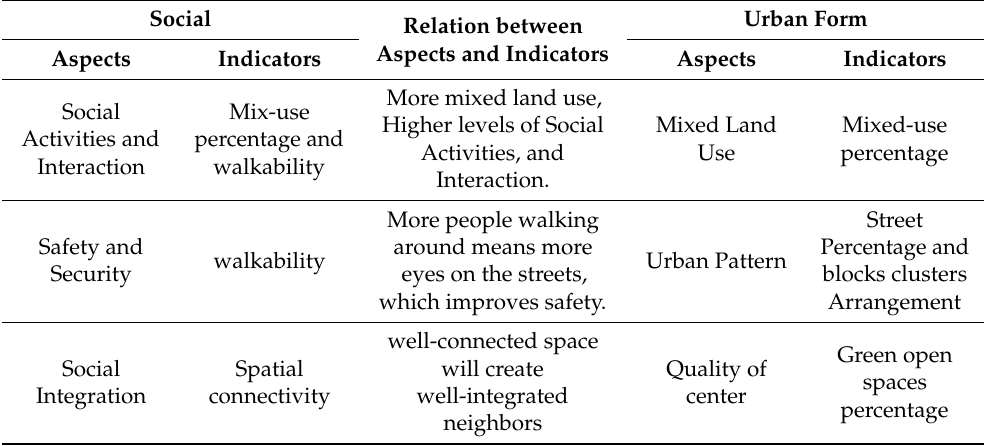
Figure 1. Matrix and expressing the relation between variables . Source: Adapted by the research- ers . Retrieved from [5,16,26,31,40–42]. Table 1. Social and Urban Form Aspects (Measurement and Evaluated Scale). Source: Adapted by Researchers Retrieved from